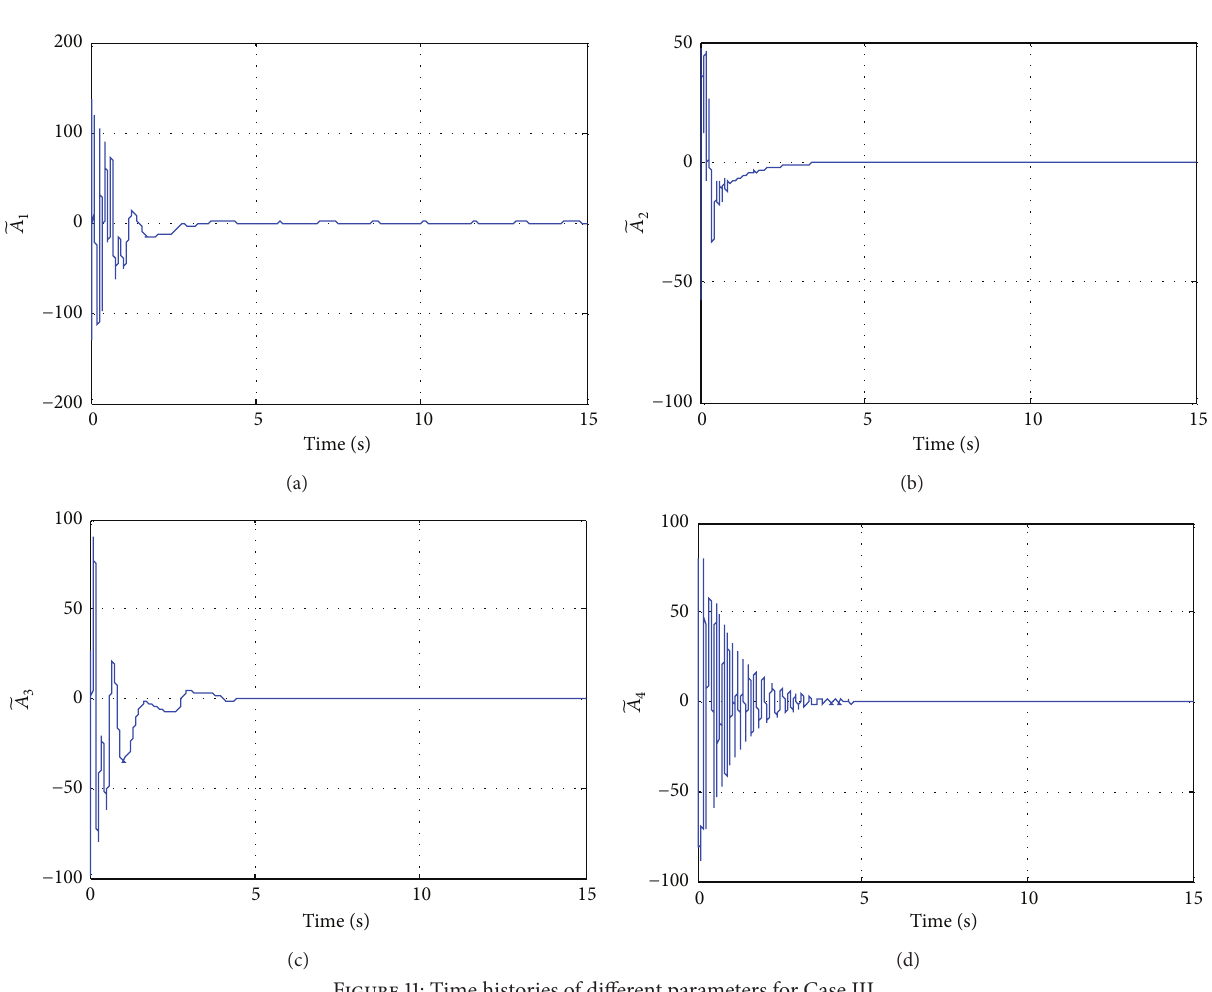
Figure 11: Time histories of different parameters for Case